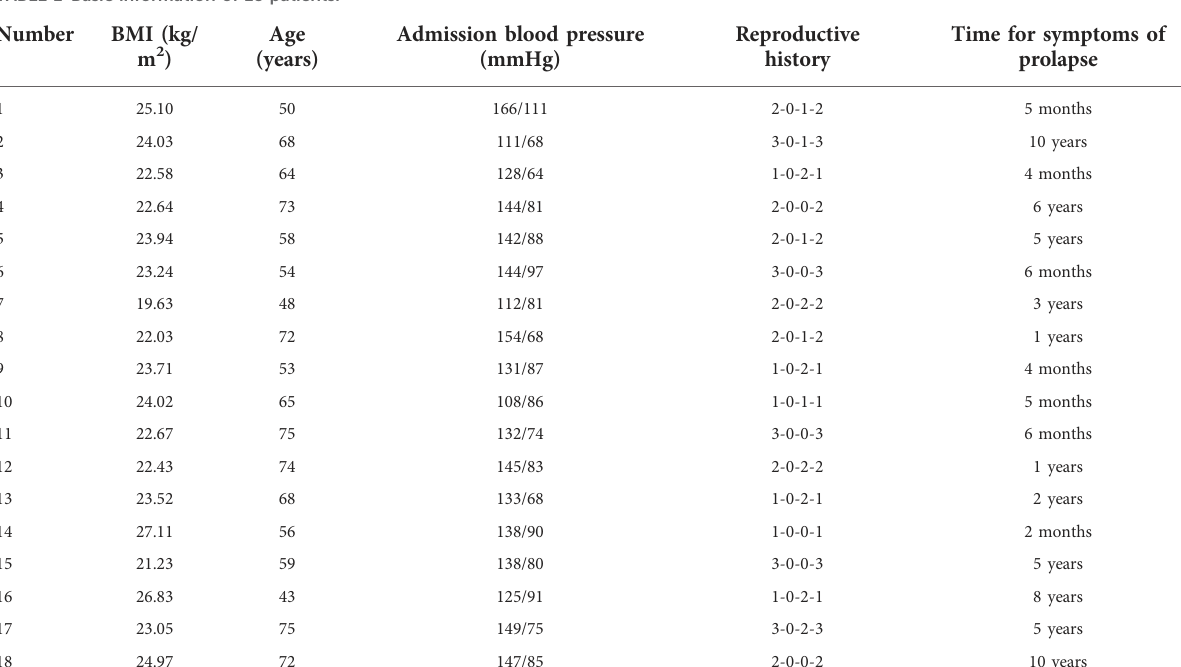
TABLE 1 Basic information of 18